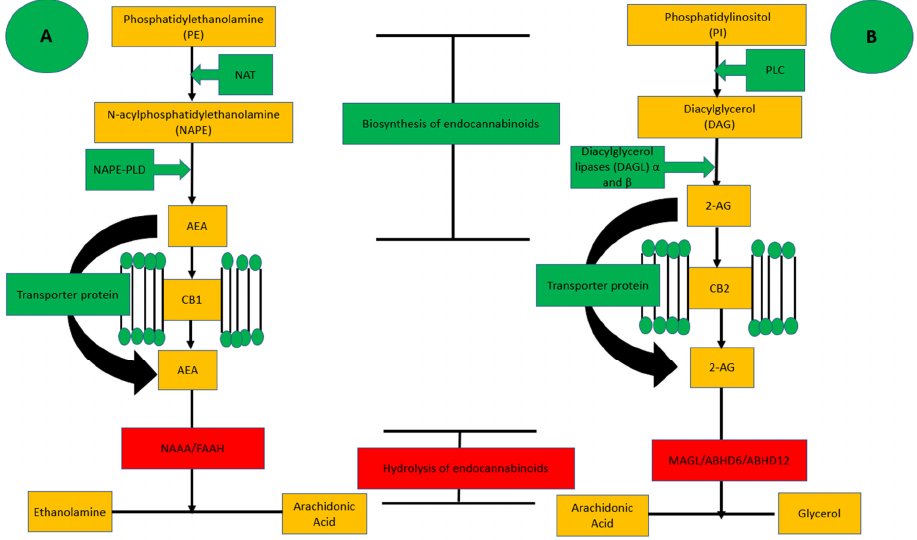
Figure 2. ( A , B ): showing the biosynthesis and hydrolysis steps of AEA and 2-AG.